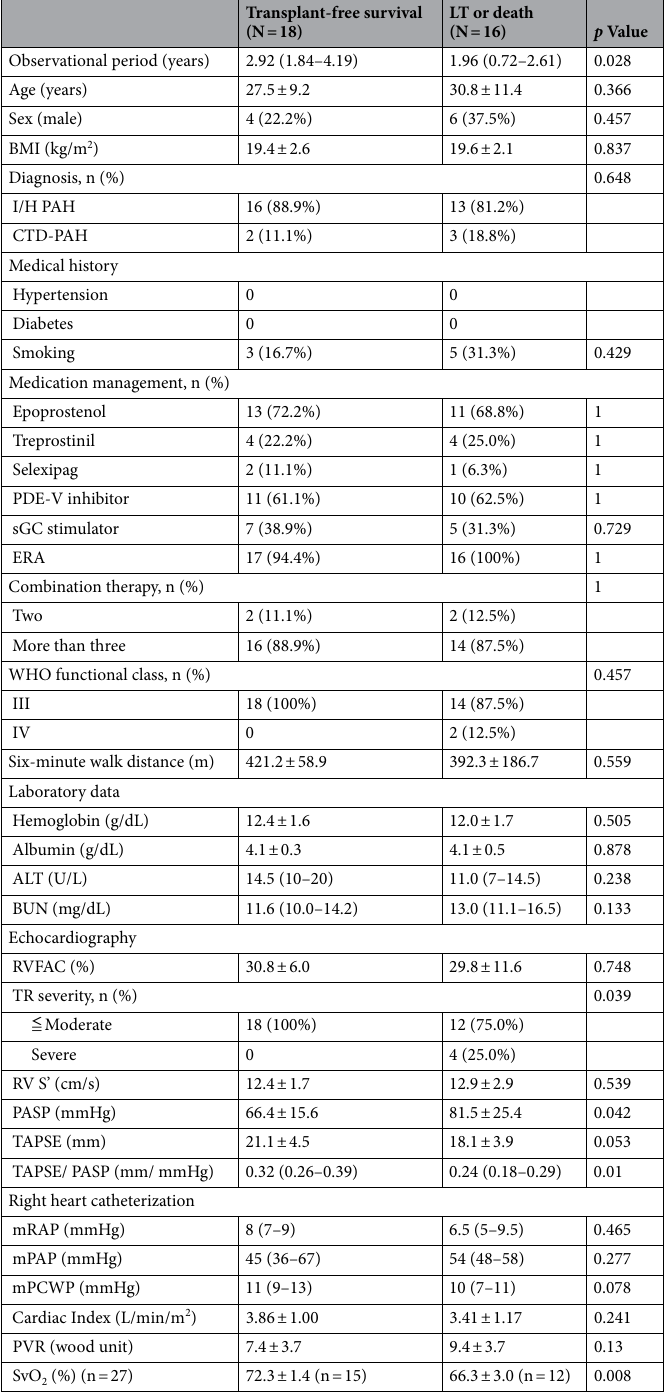
Table 1. Baseline characteristics of PAH patients referred for lung transplant evaluation. ALT alanine aminotransferase, BMI body mass index, BUN blood urea nitrogen, CTD-PAH connective tissue disease associated pulmonary arterial hypertension, ERA endothelin receptor antagonist, I/H PAH idiopathic/ hereditary pulmonary arterial hypertension, mPAP mean pulmonary arterial pressure, mPCWP mean pulmonary capillary wedge pressure, mRAP mean right atrial pressure, PASP pulmonary arterial systolic pressure, PVR pulmonary vascular resistance, RVFAC right ventricular fractional area change, RV S’ systolic annular tissue velocity of the lateral tricuspid annulus, sGC soluble guanylate cyclase stimulator, SvO 2 mixed venous oxygen saturation, TAPSE tricuspid annular plane systolic excursion, TR tricuspid regurgitation, WHO World Health